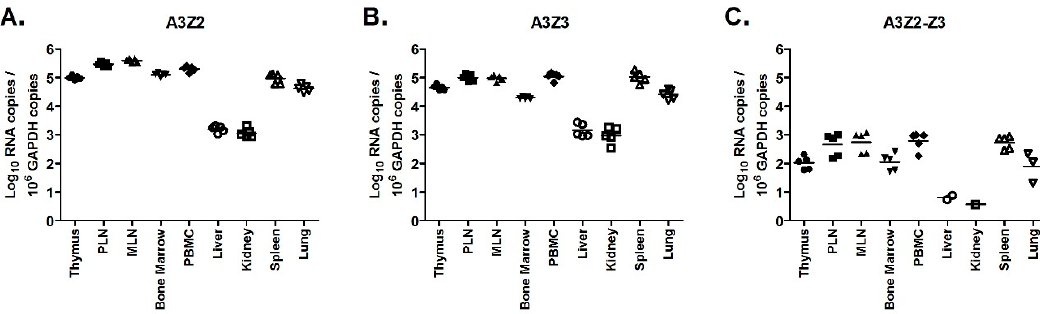
Figure 6. Basal expression of A3 mRNAs is highest in lymphoid tissue. Gene expression in tissues from uninfected cats ( n = 5) was determined for A3Z2 ( A ), A3Z3 ( B ), and A3Z2-Z3 ( C ). PLN, prescapular lymph node; MLN, mesenteric lymph node. Lines indicate mean copy number for each group. Liver and kidney had significantly lower expression than all other tissues for all A3 mRNAs ( p < 0.05).